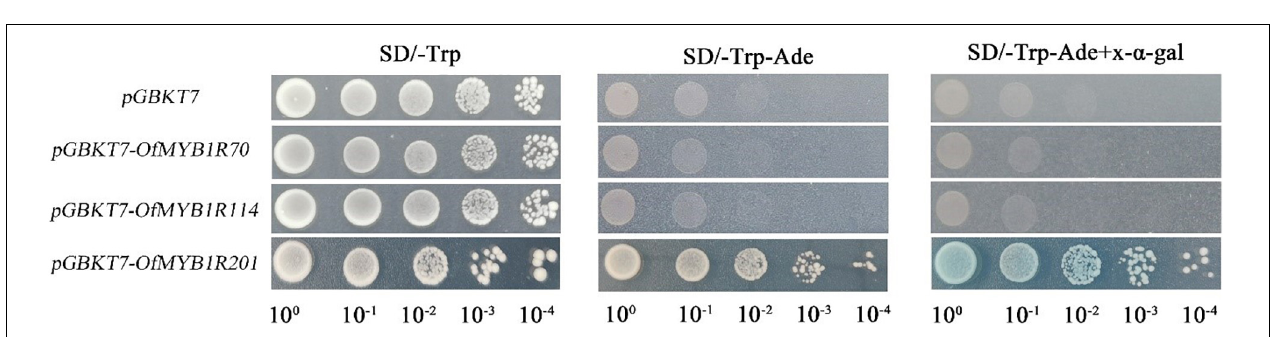
FIGURE 6 | Transcriptional activation analysis of candidate OfMYB1Rs . Growth of transformants containing pGBKT7 and pGBKT7-OfMYB1R70/114/201 on SD/-Trp medium with serial dilutions. Only pGBKT7-OfMYB1R201 survived and turned blue on SD/-Trp-Ade medium in the presence of X-A-gal.